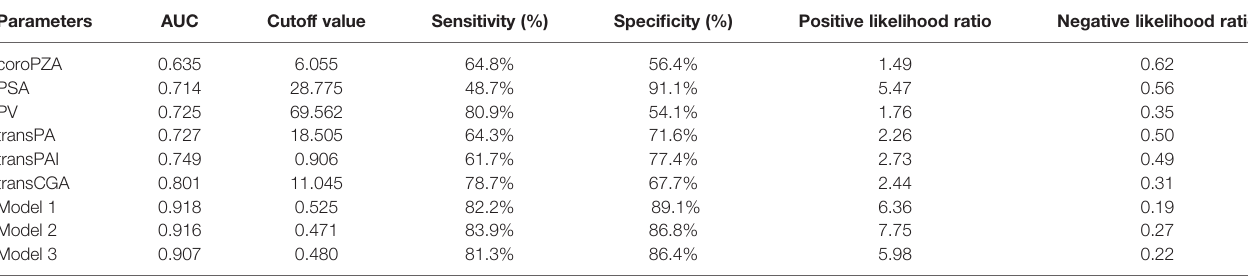
TABLE 4 | The AUC and cutoff values for predicting biopsy outcome and their sensitivity, speci fi city, and positive and negative likelihood ratios for PCa. Parameters